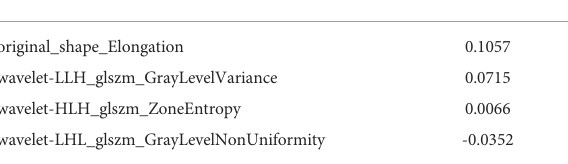
TABLE 2 Extracted features and their coef fi cients.